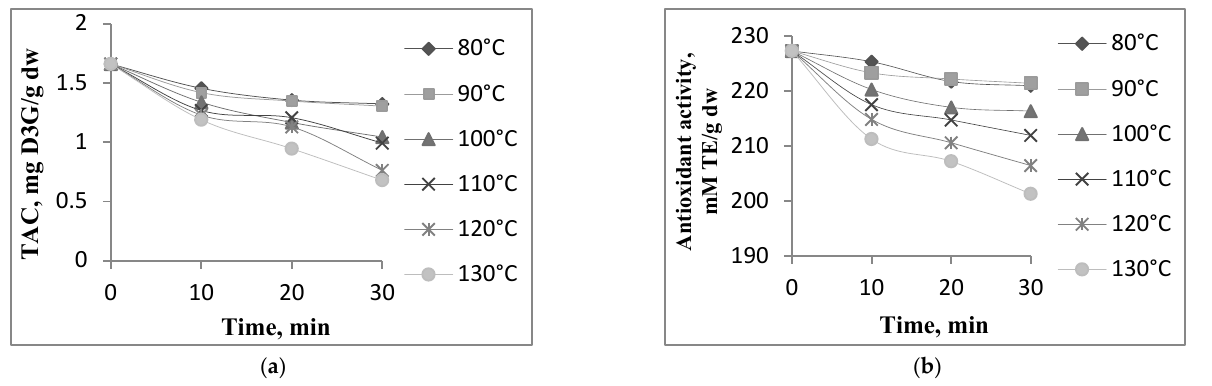
Figure 4. Degradation of total anthocyanin content—TAC ( a ) and antioxidant activity ( b ) in eggplant peel extract treated at different temperatures; D3G= delphinidin 3- O -glucoside; TE= Trolox Equivalent; dw—dry weight.